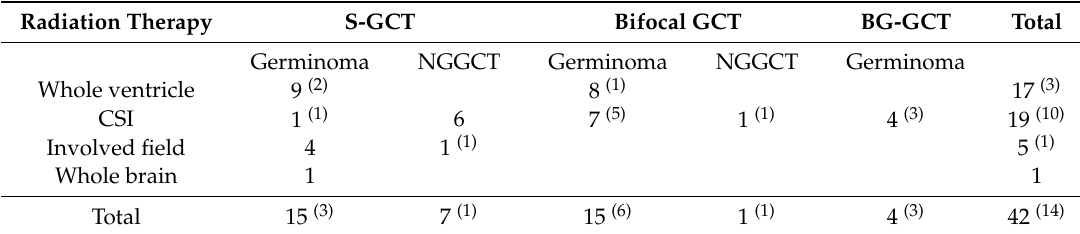
Table 4. Radiation therapy field and intraventricular